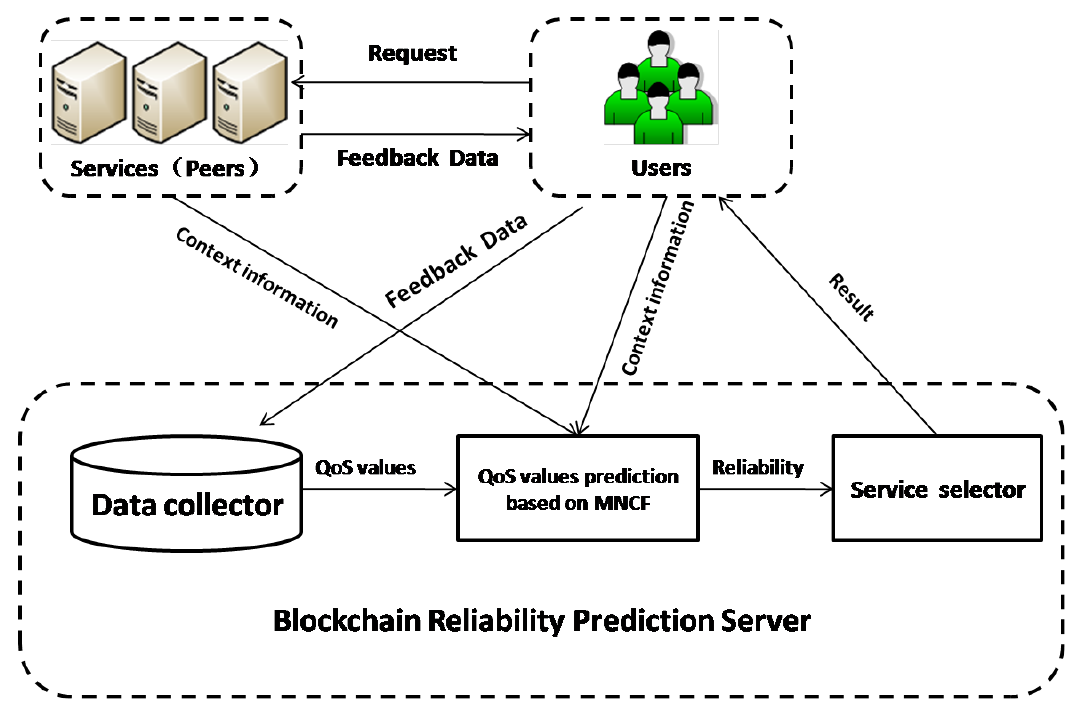
Figure 1. Reliability Prediction Framework for Blockchain